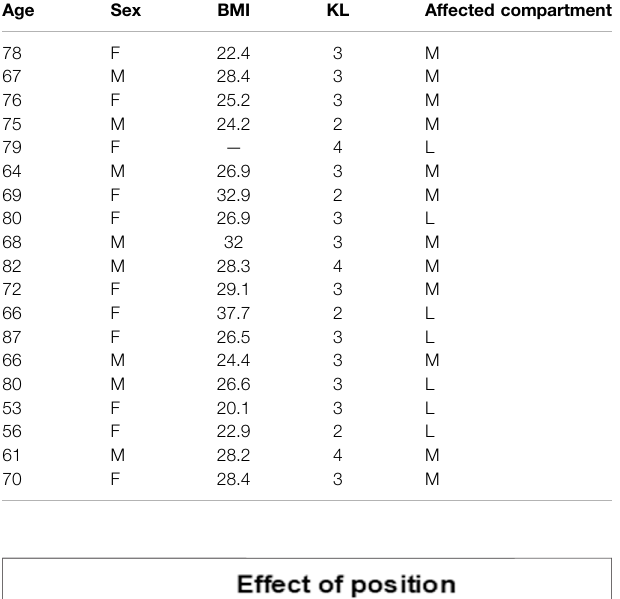
TABLE 3 | Mono-compartmental knee OA patient characteristics: age at surgery (in years), sex, body mass index (BMI, in kg/m2), radiographic score (Kellgren and Lawrence, 1957) and affected compartment (medial, M, for varus, and lateral L, for valgus